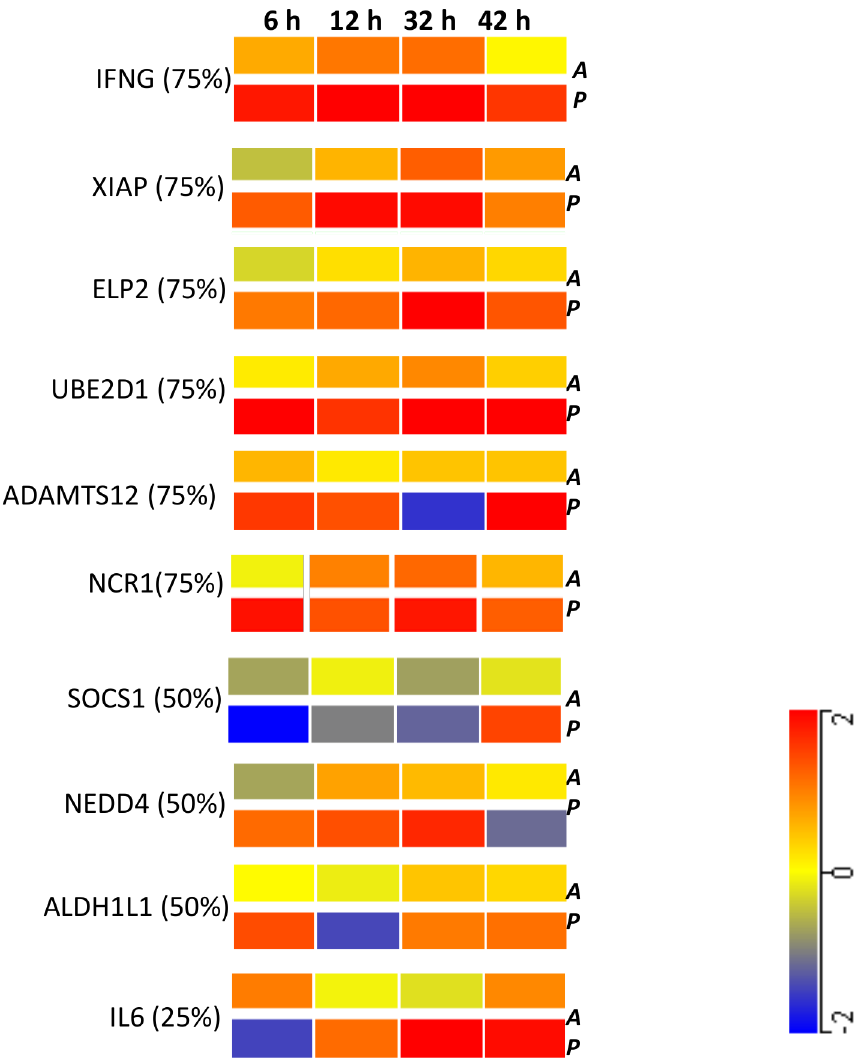
Fig 4. qPCR results of the selected genesarranged in the descending order of validation (% in parenthesis beside the gene name shows the number of genes -fold changed in same direction, >± 1.5) between Array ( A , top row) vs. qPCR ( P , bottom row) across the timecourse, two from Early (6 h and 12 h) and two from Late timegroups (32 h and 42 h). The color scale presented in the bottom right corner shows the gradient of fold change with red upregulated, blue downregulated and yellow no change in gene